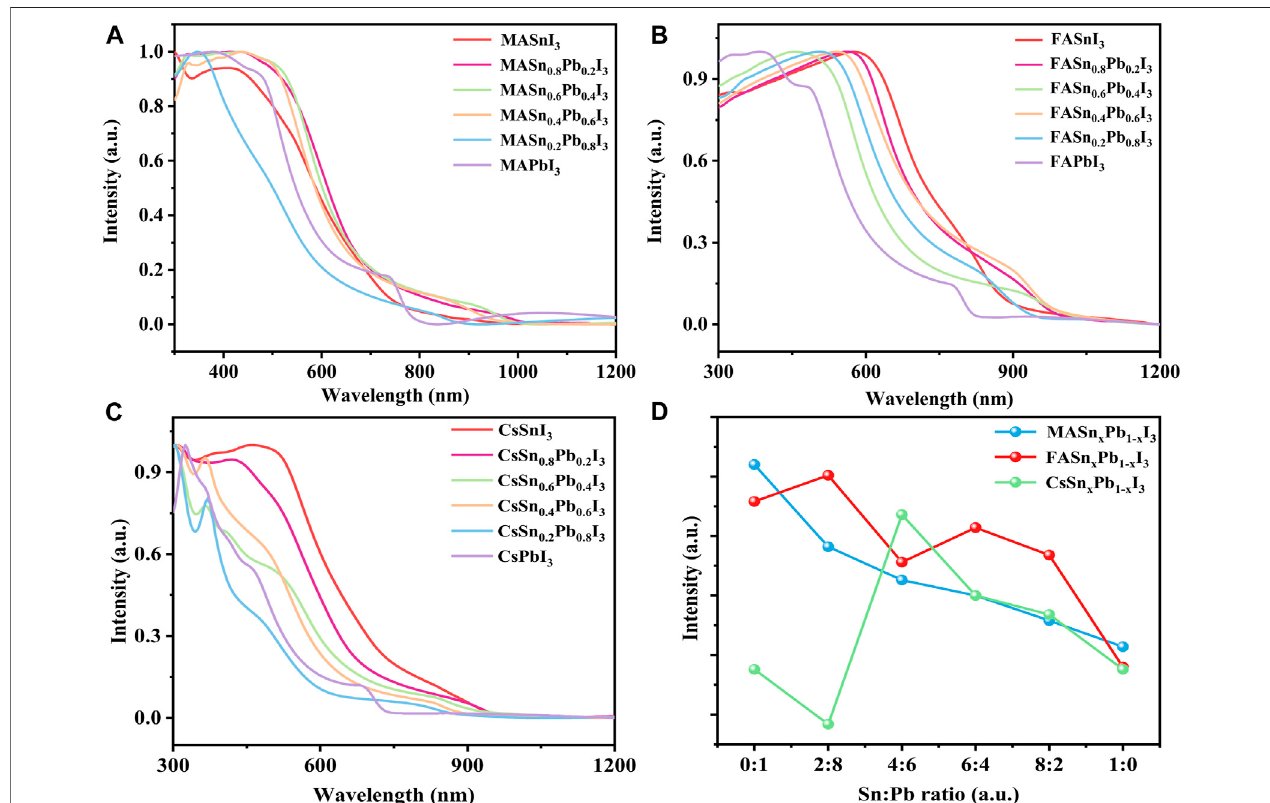
FIGURE 2 | Optical absorption properties of (A) MASn x Pb 1-x I 3 , (B) FASn x Pb 1-x I 3 and (C) CsSn x Pb 1-x I 3 ; (D) absorption intensity for each composition.